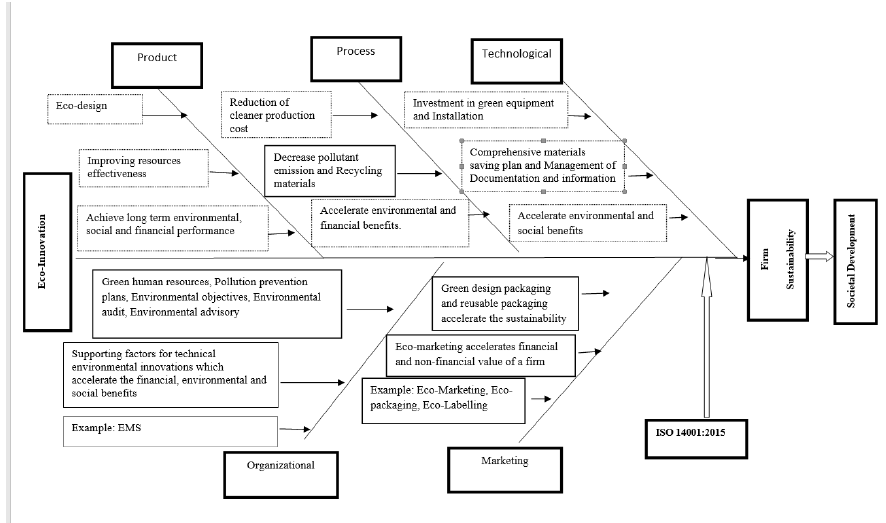
Figure 2. Conceptual framework on eco-innovation, firm sustainability, societal developments, and ISO 14001:2015 (authors’ own elaboration). and ISO 14001:2015 (authors’ own